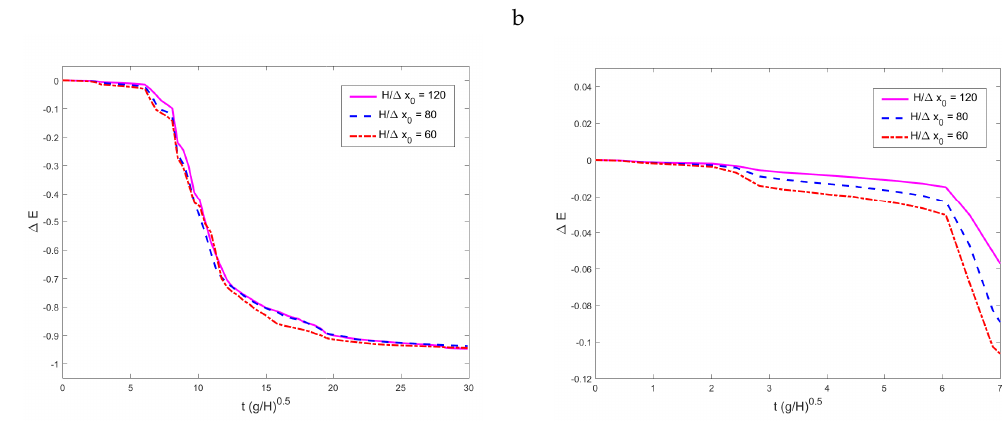
Figure 16. Two-dimensional dam-break flow. Figure ( a ) shows the time evolution of mechanical energy. Figure ( b ) plots the results obtained by the proposed method with different particle resolution. A zoom of the region of the curve before the first splash-up is displayed on the right.